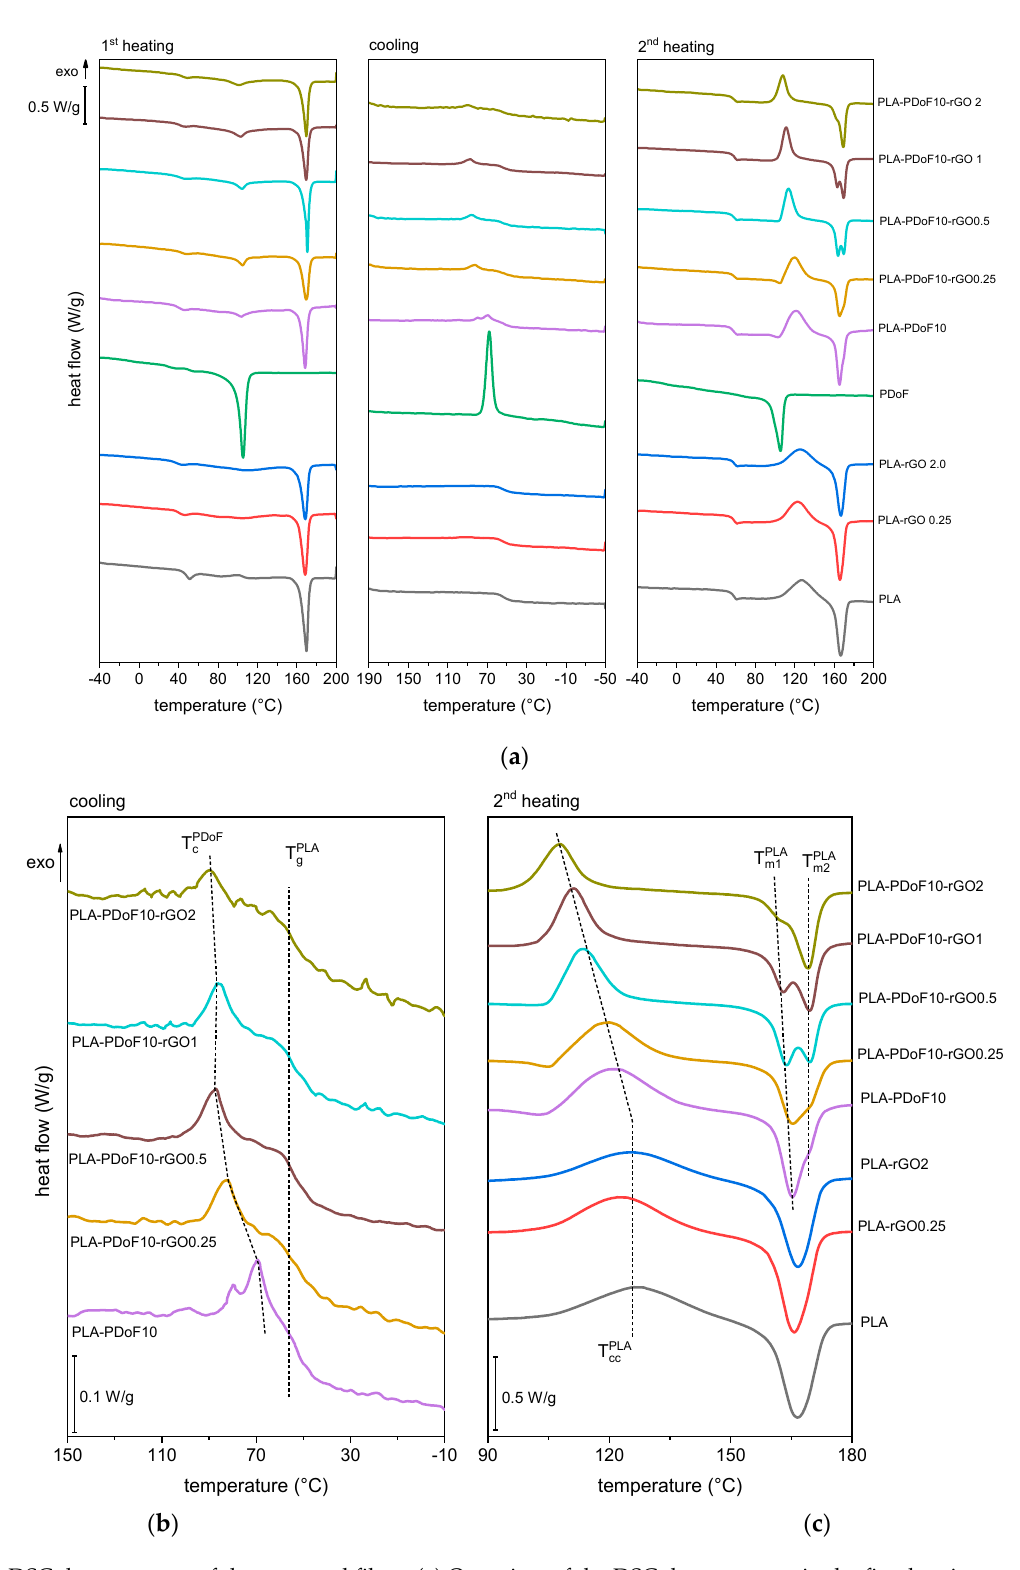
Figure 6. DSC thermograms of the prepared films. ( a ) Overview of the DSC thermograms in the first heating, cooling, and second heating scans; ( b ) Detail of the cooling scan with an indication of the crystallization temperature of the PDoF phase and the glass transition temperature of PLA; ( c ) Detail of the second heating scan with indication of the cold crystallization temperature of the PLA phase and the double melting behavior of PLA. Table 2. Main results of the DSC tests on the prepared samples.